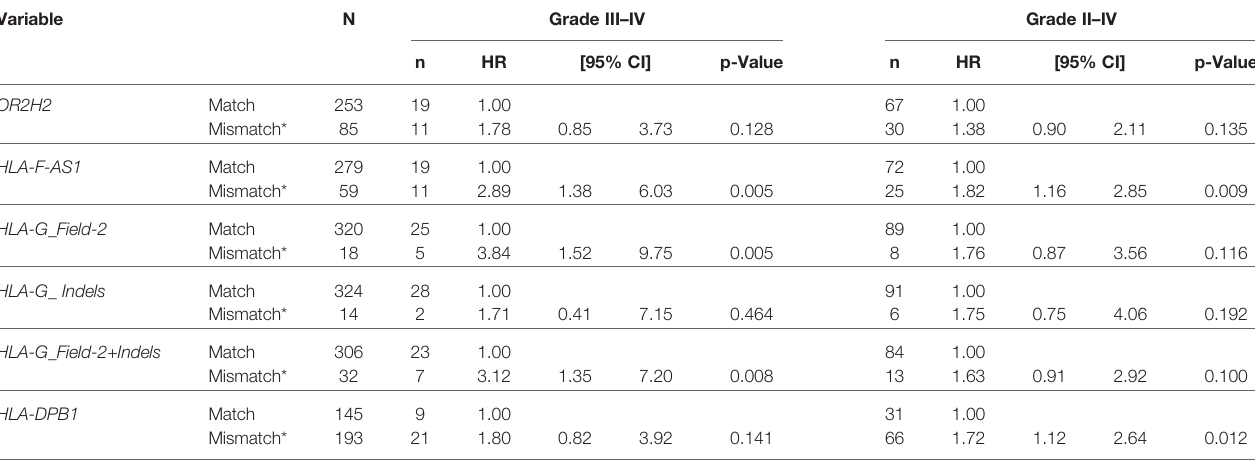
TABLE 4 | Effect of HLA-F-AS1 , HLA-G , and HLA-DPB1 mismatches on aGVHD by the univariate analysis. Variable N